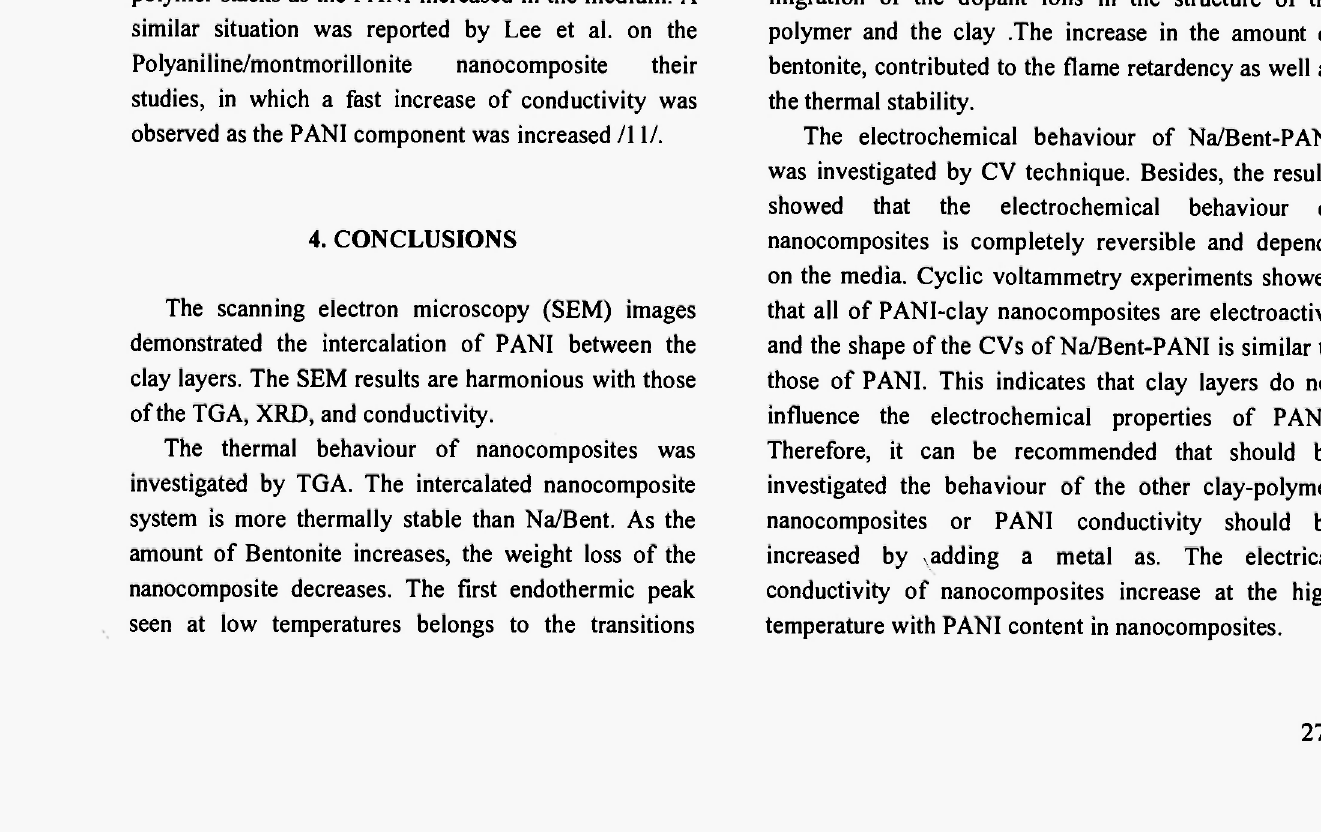
Fig. 6: The conductance of the Na/Bent-PANI nanocomposite at room temperature and 383 Κ in different aniline